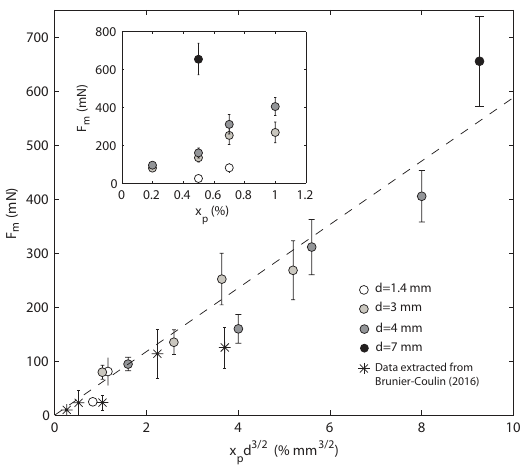
Figure 2. Micro-tensile force F m as a function of x p d 3 / 2 . The dashed line stands for y = α x , with the fit parameter α = 59 Inset: F m as a function of x p .